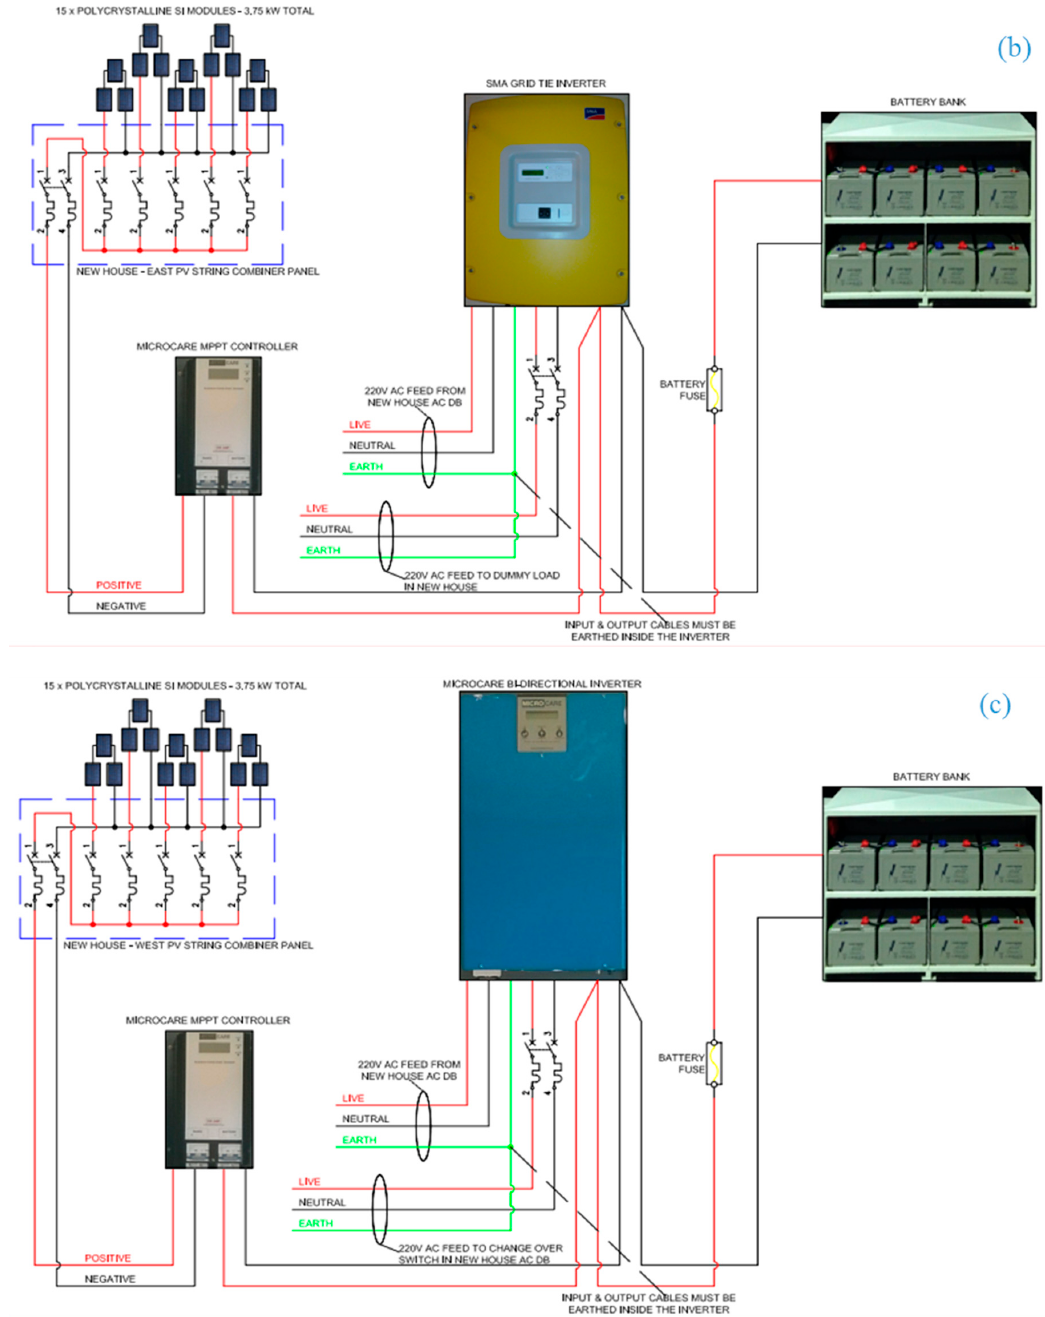
Figure 3. Wire diagram of the component balance of system in ( a ) off-grid, ( b ) hybrid, and ( c ) grid- assisted microgrid systems at SolarWatt